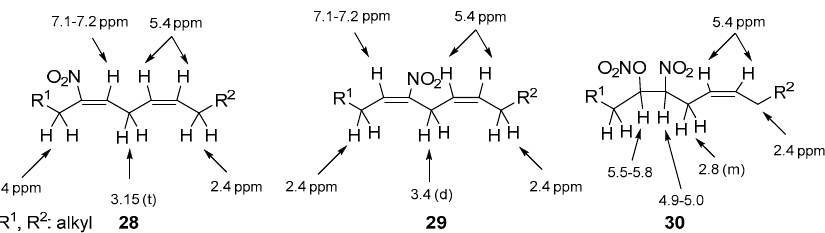
Figure 9. Gas-induced synthesis of nitro isomers and some of their characteristic 1 H-NMR shifts [101].